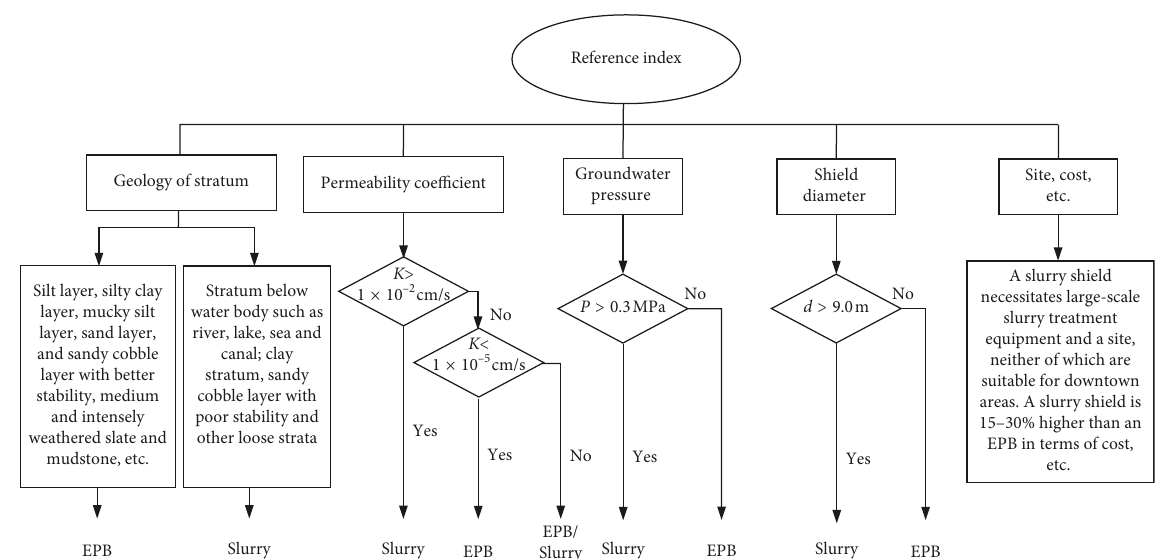
Figure 5: Main considerations underpinning the shield type selection [18, 19].